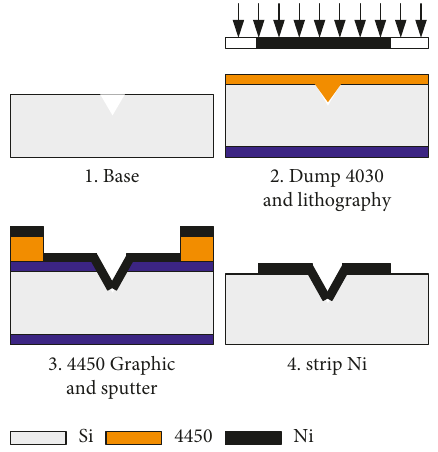
Figure 6: Process flow of the lower electrode of the micro-